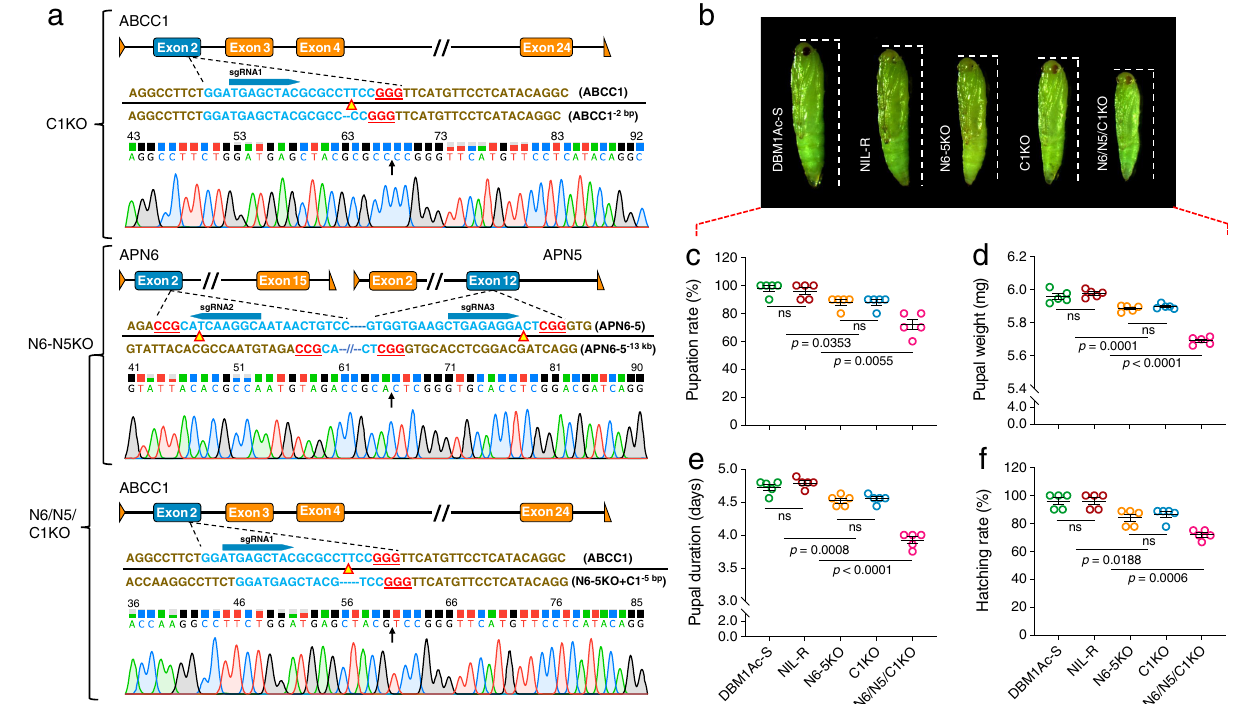
Fig. 7| CRISPR/Cas9-mediated knockoutofnon-receptorgenesin P.xylostella . a Representative chromatogram of CRISPR/Cas9-induced mutation of ABCC1 gene (top), double-gene knockout of APN6 and APN5 genes (middle), and triple mutant of ABCC1/APN6/APN5 genes by introducing mutations on the base of the double- mutant (bottom). The cleavage site of Cas9 protein is indicated with a red-edged yellow triangle. The arrow indicates the junction position after deletion. b Representativepupalmorphologyin P.xylostella susceptibleDBM1Ac-S,resistant NIL-R, and non-receptor gene-edited strains. c – f Evaluation of fi tness costs in non-